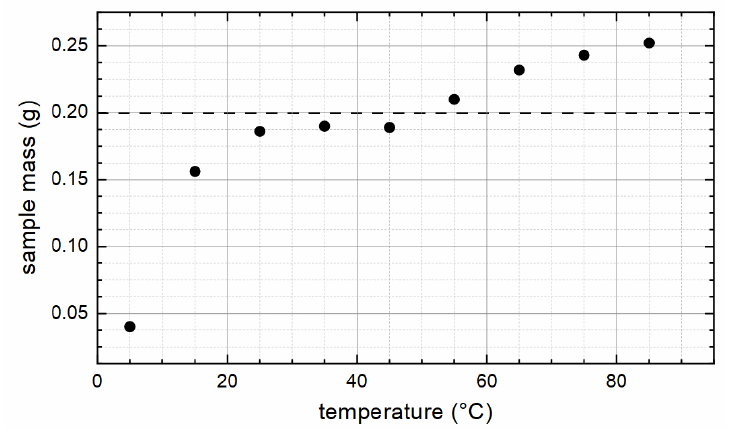
Figure 1. Total weight of the synthesized samples for each reaction temperature. The dashed line marks the maximum amount, if pure maghemite is formed. Table 1. XRD and VSM results for all particles.